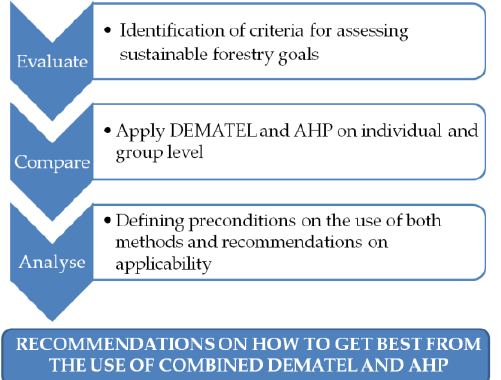
Figure 1. Modeling and analysis framework based on use of DEMATEL and